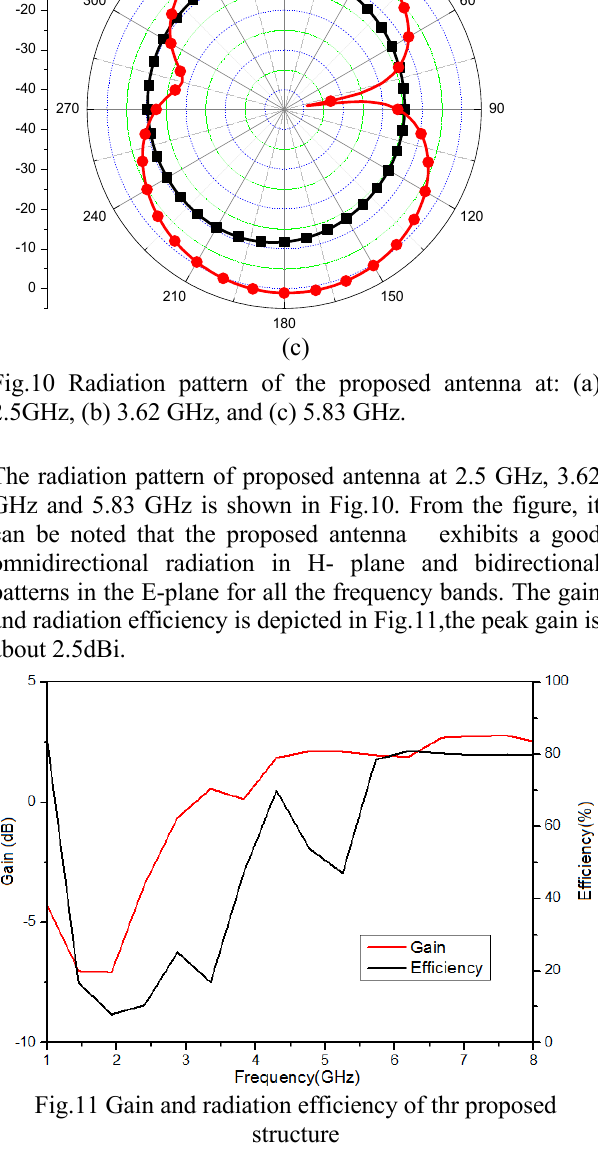
Fig.11 Gain and radiation efficiency of thr proposed